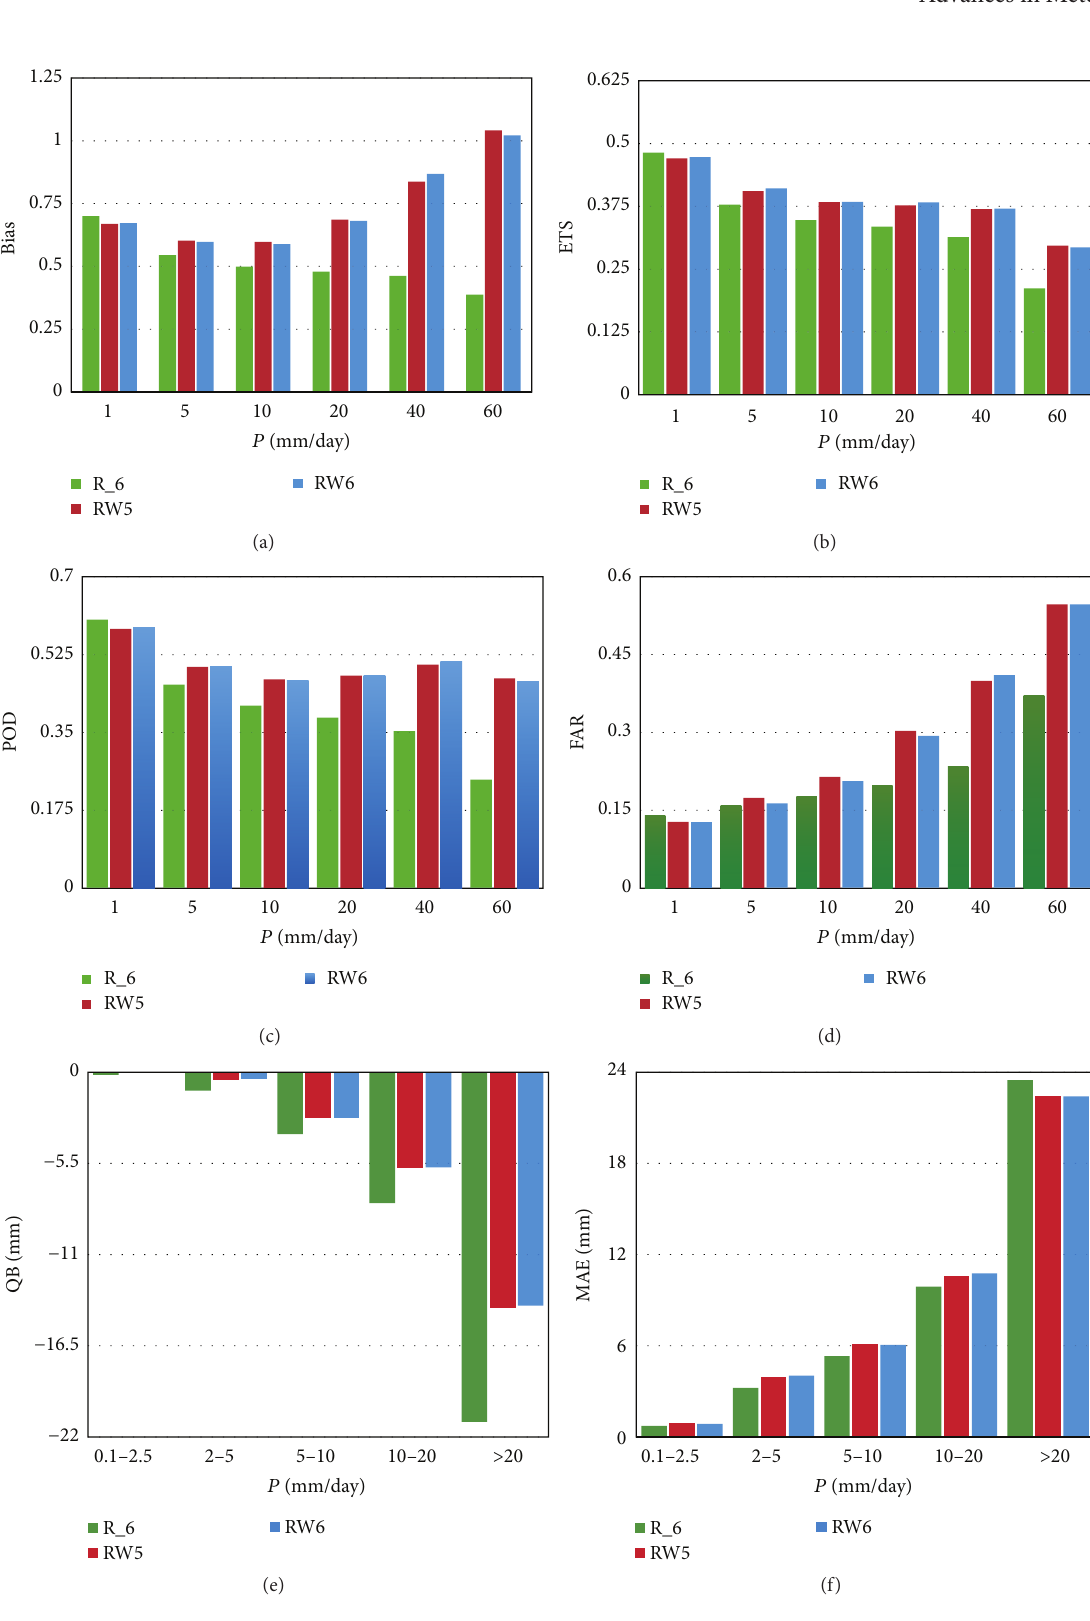
Figure 5: Objective scores computed from contingency tables and quantitative statistics for the precipitation over the Italian area: (a) bias; (b) equitable threat score (ETS); (c) probability of detection (POD); (d) false alarms rate (FAR); (e) quantitative bias (QB); (f) mean absolute error (MAE). R 6 is in green, RW5 in red, and RW6 in